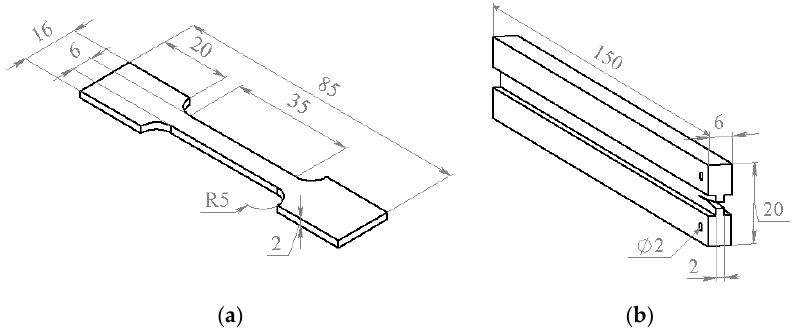
Figure 1. The specimens used for the tensile strength ( a ) and the crack resistance ( b ) measurements. The samples shown in Figure 1b were used for the crack resistance measurements.